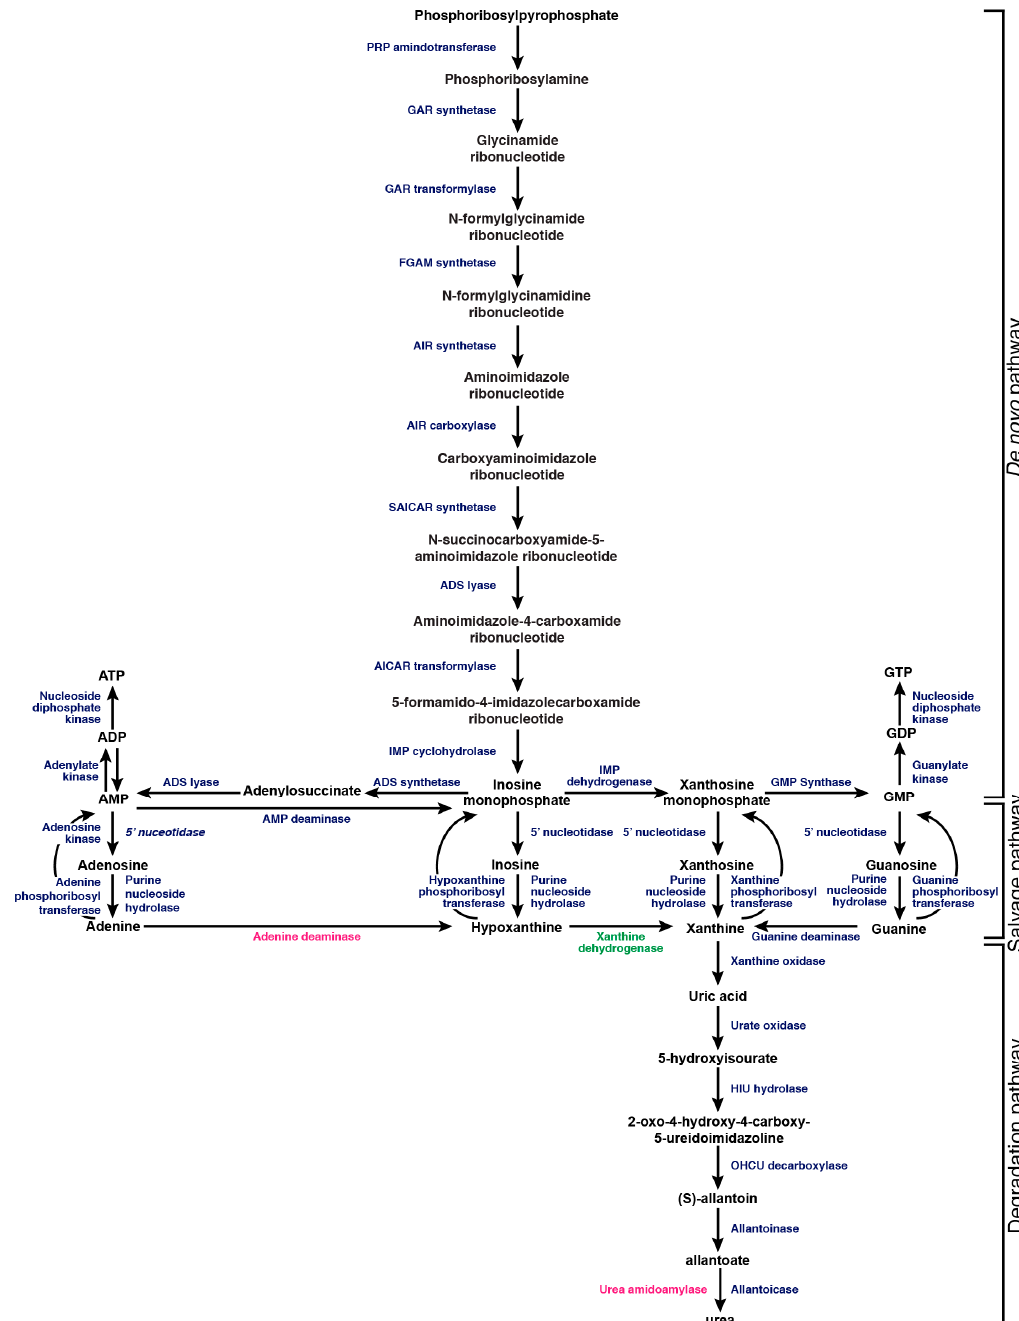
Figure 1. Blue represents enzymes found in C. albicans , A. fumigatus, and C. neoformans . Pink represents an enzyme found in both C. albicans and A. fumigatus . Green represents an enzyme found in A. fumigatus only. Abbreviated enzyme names: PRP (Phosphoribosylpyrophosphate) amidotransferase, GAR (glycinamide ribotide) synthetase, GAR (phosphoribosyl-glycinamide) transformylase, FGAM (formylglycinamidine-ribonucleotide) synthetase, AIR aminoimidazole ribotide) synthetase, AIR (Phosphoribosylaminoimidazole) carboxylase, SAICAR (N-succinyl-5-aminoimidazole-4-carboxamide ribotide) synthetase, ADS (adenylosuccinate) lyase, AICAR (5-aminoimidazole-4-carboxamide ribonucleotide) transformylase, IMP (inosine monophosphate) cyclohydrolase, ADS (adenylosuccinate) synthetase, IMP (inosine monophosphate) dehydrogenase, GMP (guanine monophosphate)